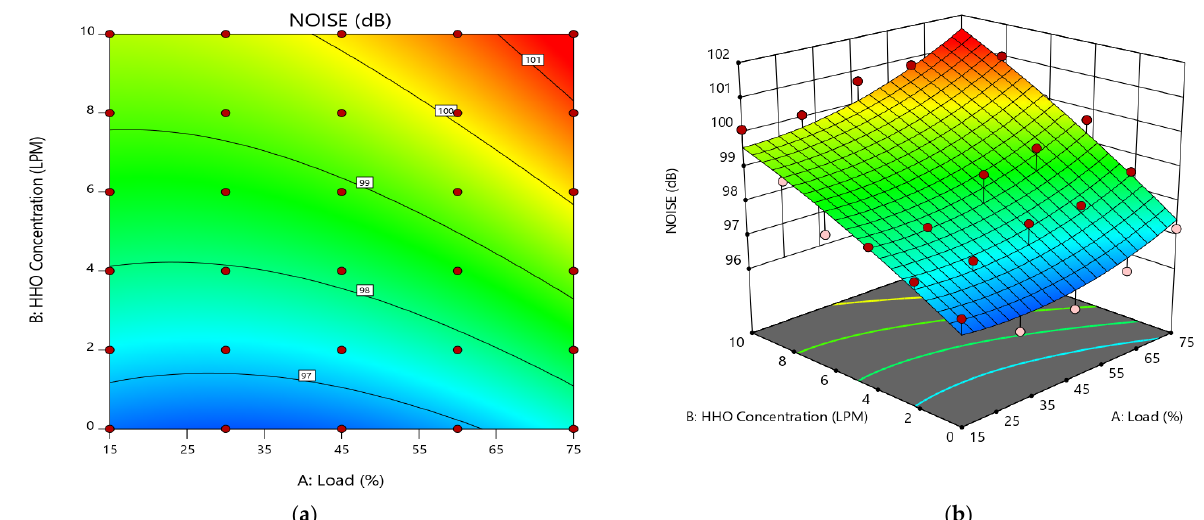
Figure 12. ( a ) Contour plot and ( b ) response surface of noise.